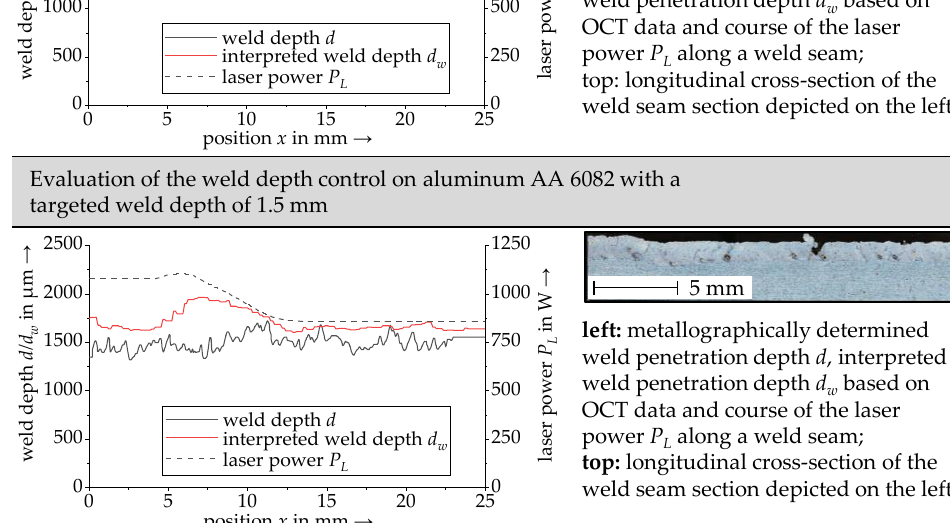
top: longitudinal cross-section of the